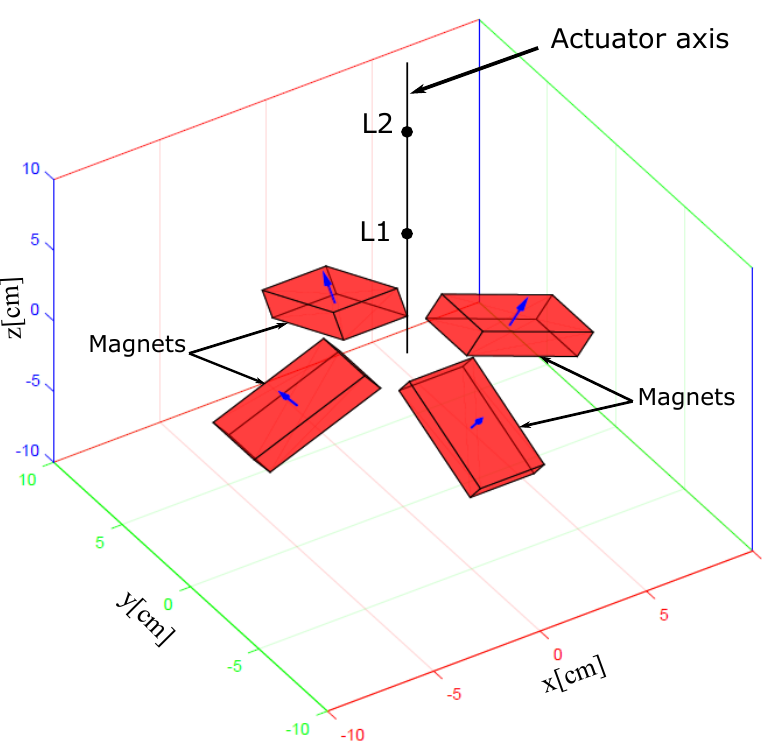
Figure 2. Four permanent magnets based actuator configuration.